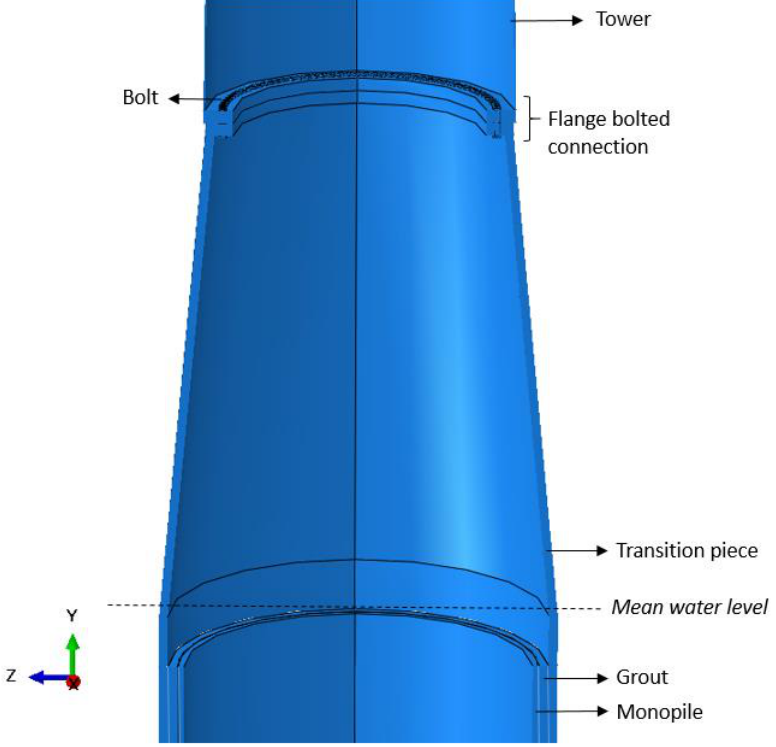
Figure 6. Three-dimensional complex model.